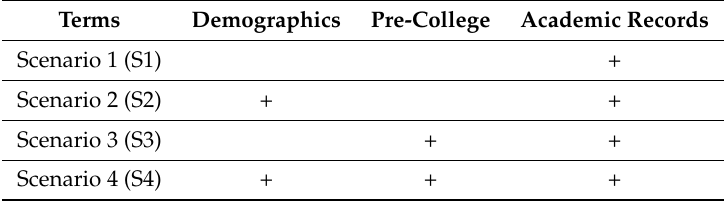
Table 3. Experiment scenarios (+ indicates inclusion of the feature